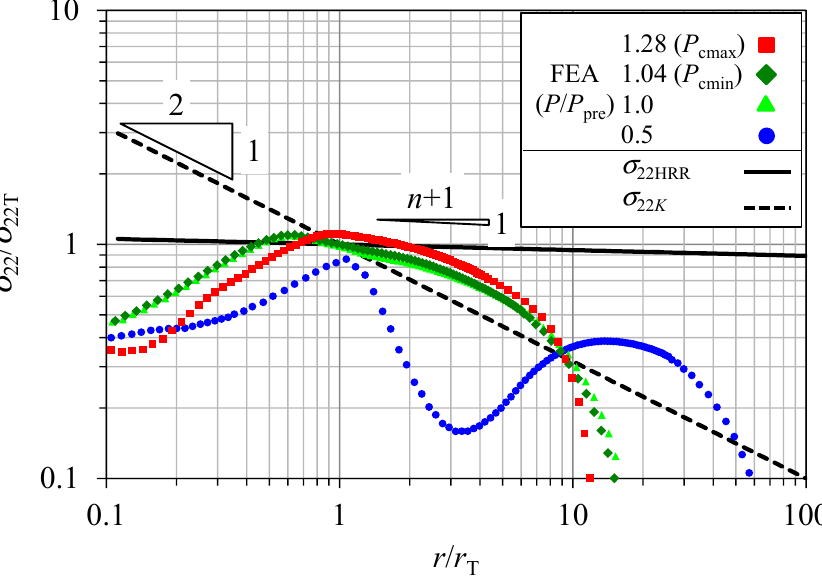
Figure 6. Midplane crack-opening stress distribution with CRS for P / P pre = 0.5, 1, 1.04, and 1.28. For the load P / P pre = 0.5, the effect of CRS was observed. However, for the cases of P / P pre ≥ 1.0, the σ 22 distribution was close to that without CRS.